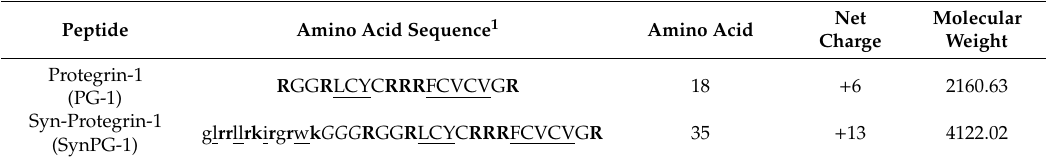
Table 1. The amino acid sequence of the studied peptides and their predicted properties.